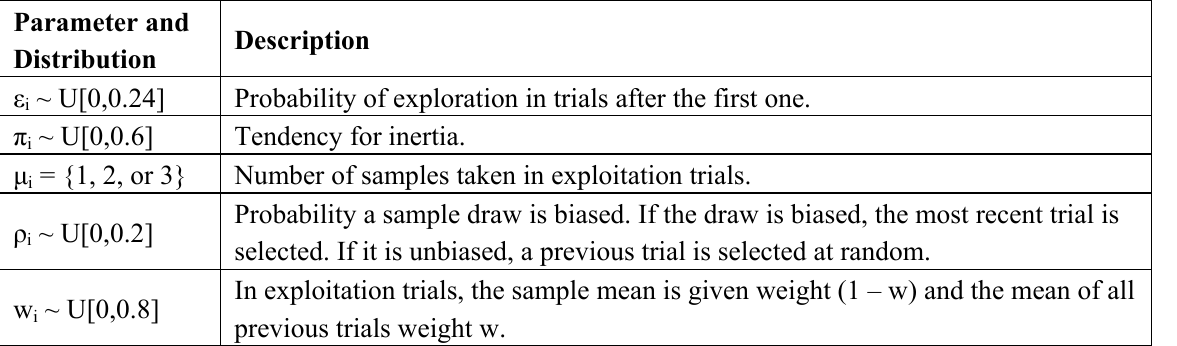
Table 1. The five trait